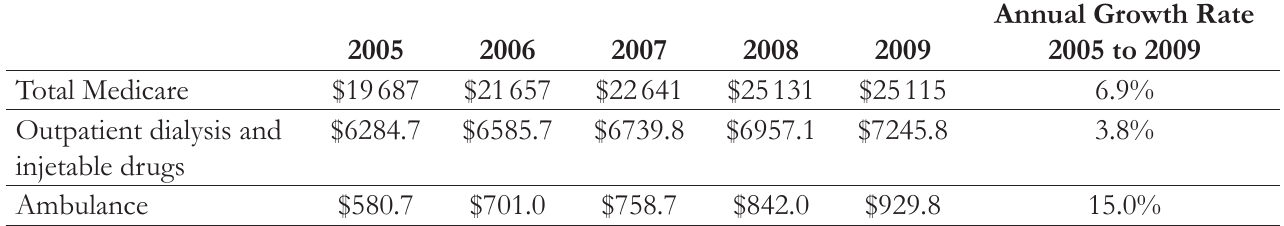
Table 9. Total Medicare Payments ($ Millions) for ESRD Patients: by Select Claim Type